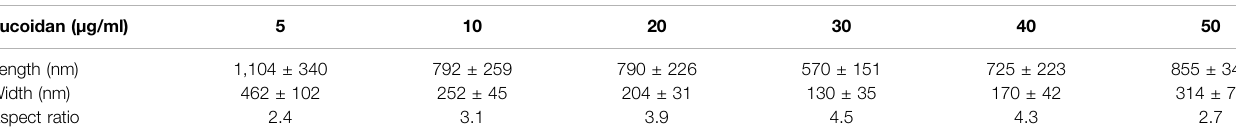
TABLE 1 | Average length and width of the calcium carbonate nanorods prepared with different fucoidan concentrations. Fucoidan